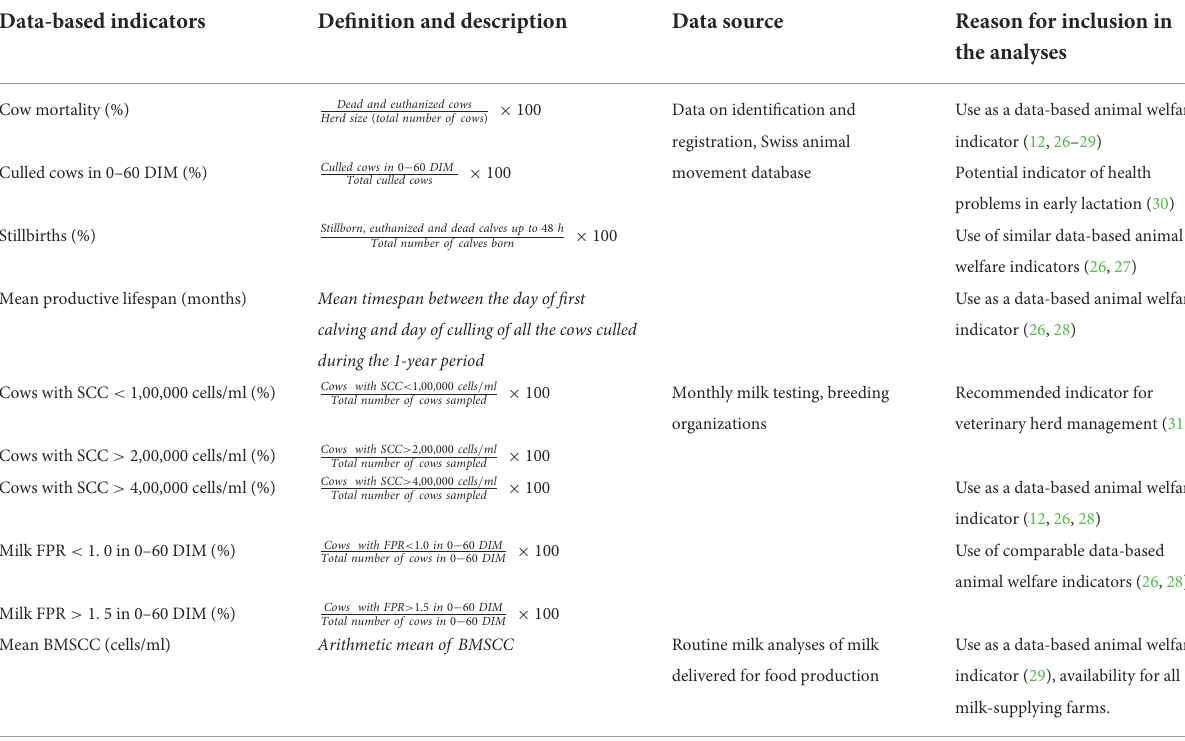
TABLE 2 Data-based indicators, and their calculations and data sources used for the present study and reasons for the inclusion in the analyzes.